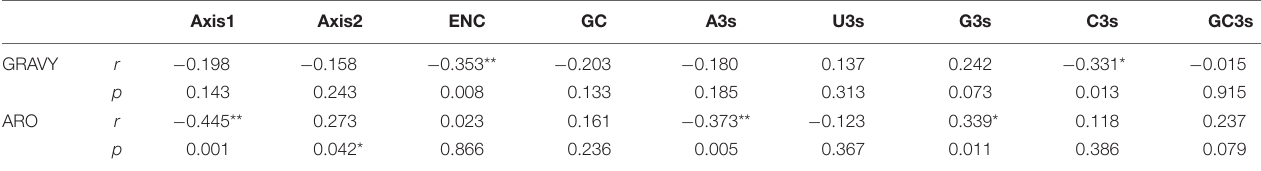
TABLE 5 | Correlation analysis among ARO, GRAVY, the first two axes, GC3s, ENC and GC in the 56 PEDV strains.